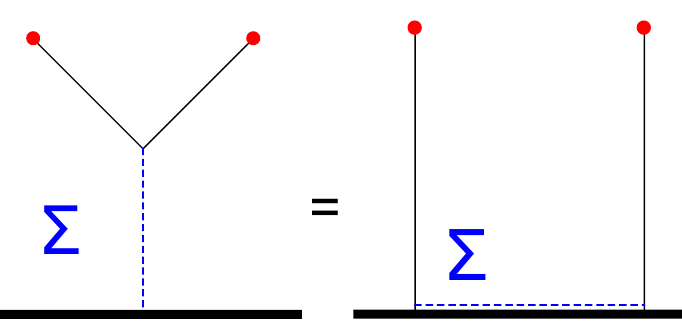
Figure 1. Crossing symmetry for two-point functions in